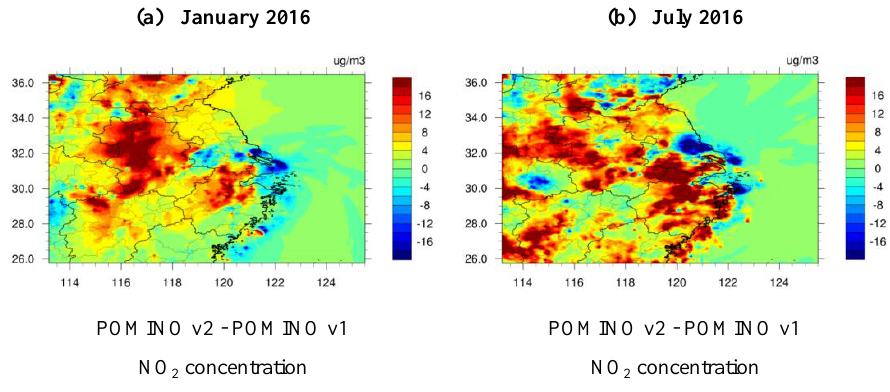
Figure 6. The spatial differences (POMINO v2 - POMINO v1) of NO 2 concentrations derived from top-down NO X emissions based on POMINO v2 and POMINO v1 in January and July